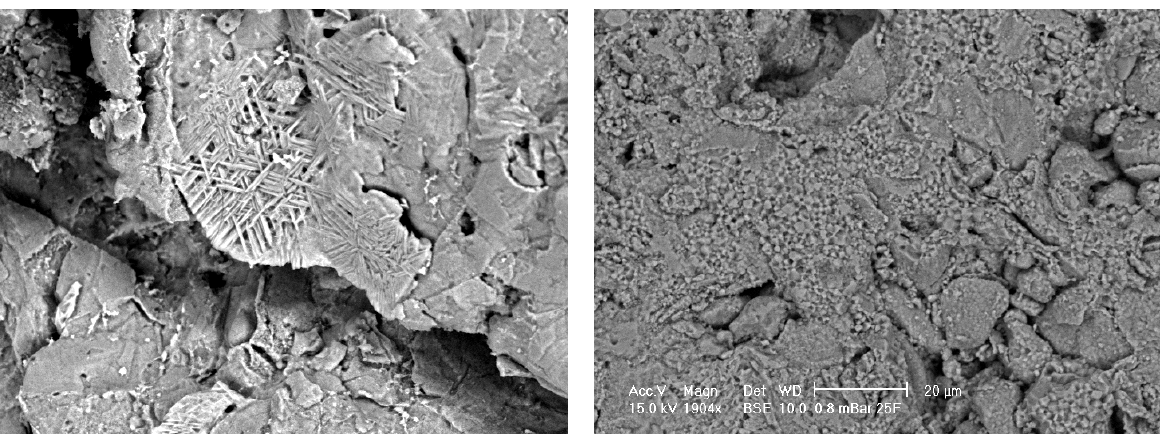
Figure 4. SEM micrographs of alumina control samples after pre-treatment with approximate magnification of 2000. Porous Sample A ( left ) shows acicular structure from etching. Less porous Sample B ( right ) shows fine structure from